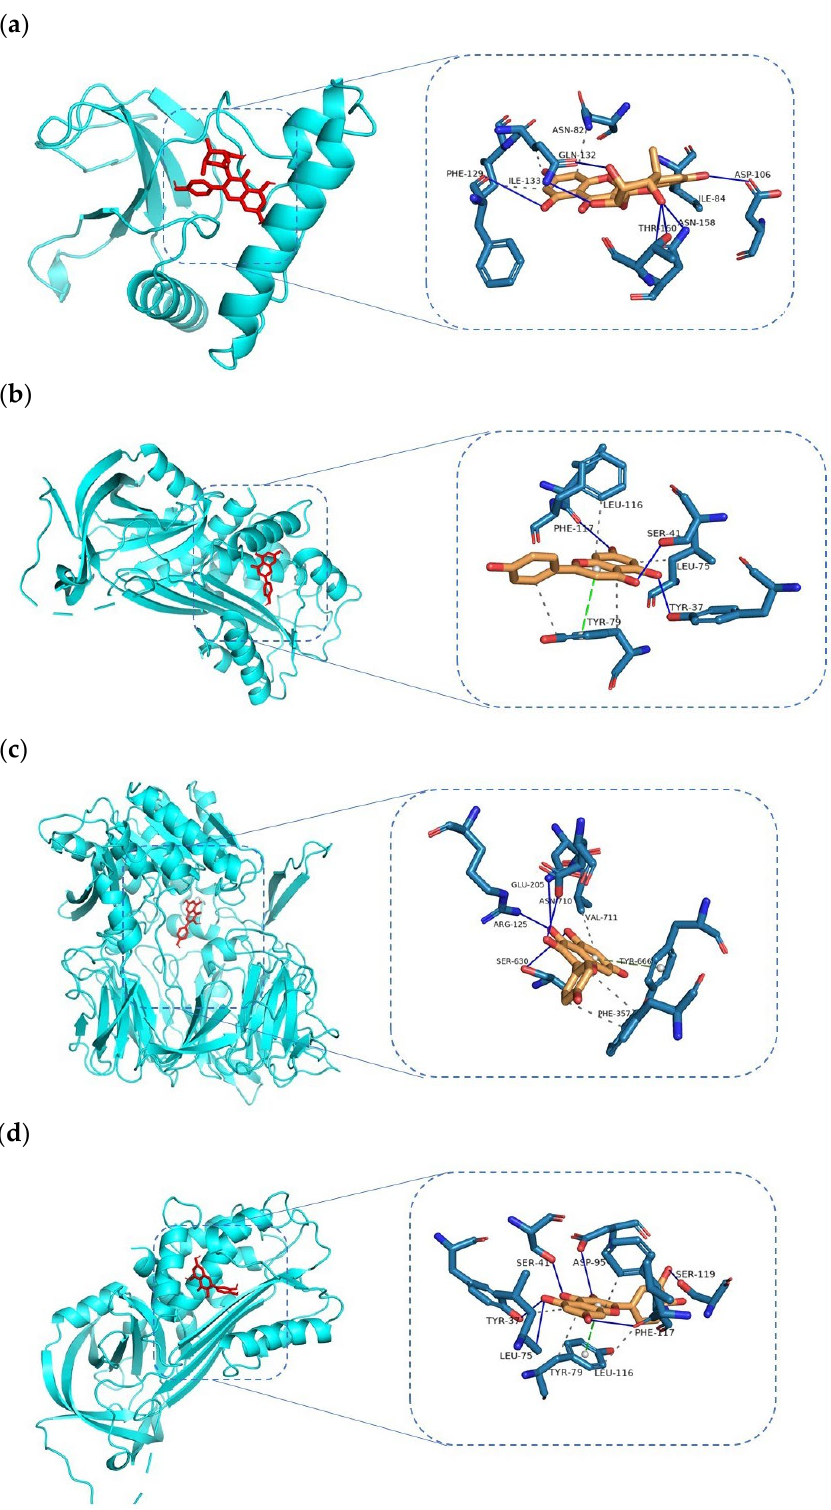
Figure 6. Docking patterns of selected key targets according to the lowest binding affinities with each active metabolite. The TARGET–metabolite complexes include ( a ) MAPK1–afzelin, ( b ) SERPINE1–apigenin, ( c ) DPP4–kaempferol, and ( d ) SERPINE1–apigenin. The binding affinities (kcal/mol) and binding residues are listed in Table 4.